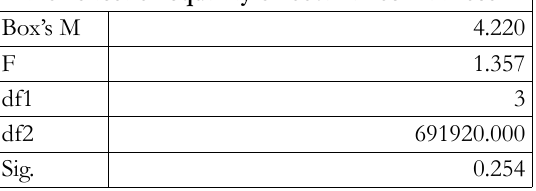
Table 8. Result of homogeneity test